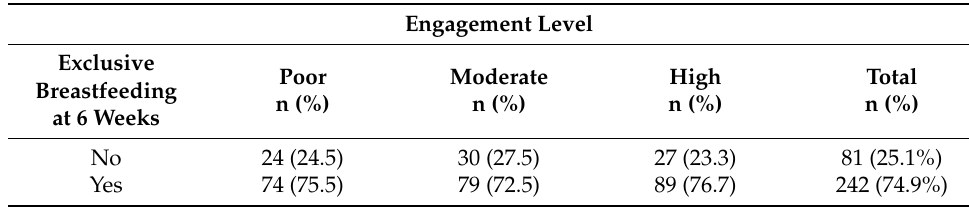
Table 3. Exclusive breastfeeding at 6 weeks by engagement